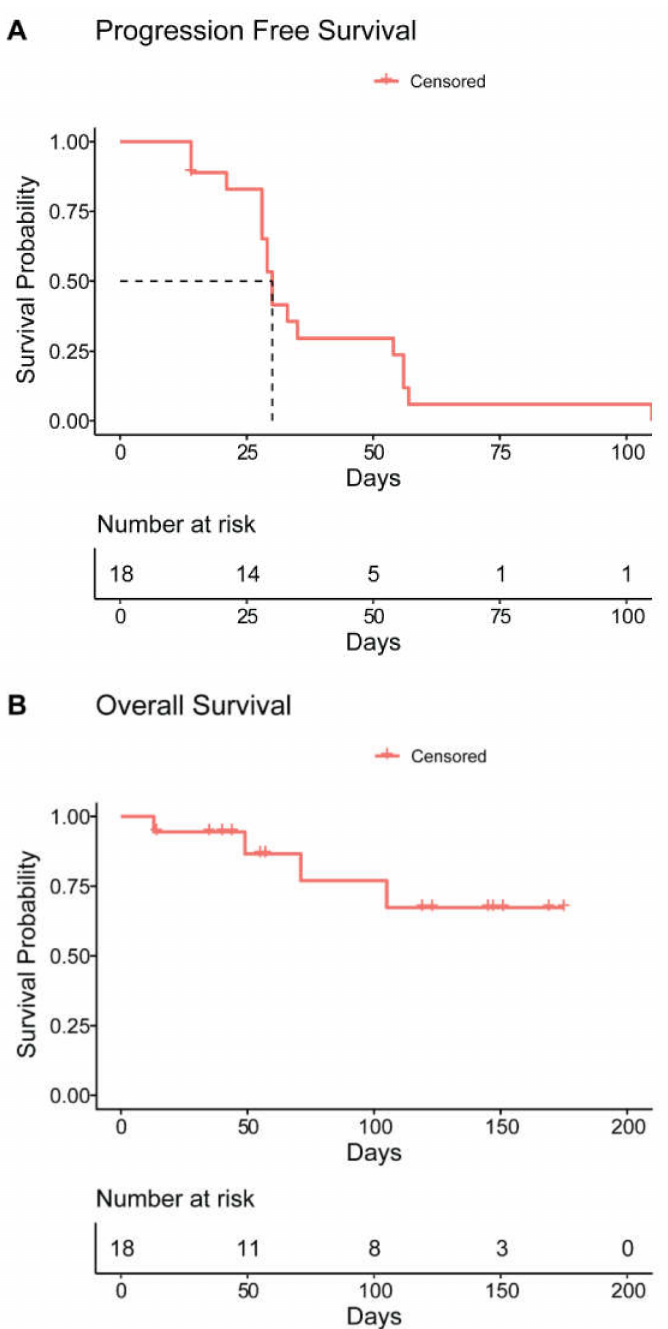
Figure 1. ( A ) Progression free survival (PFS) and ( B ) overall survival (OS) for patients treated with daratumumab and durvalumab. PFS and OS were estimated using the Kaplan-Meier